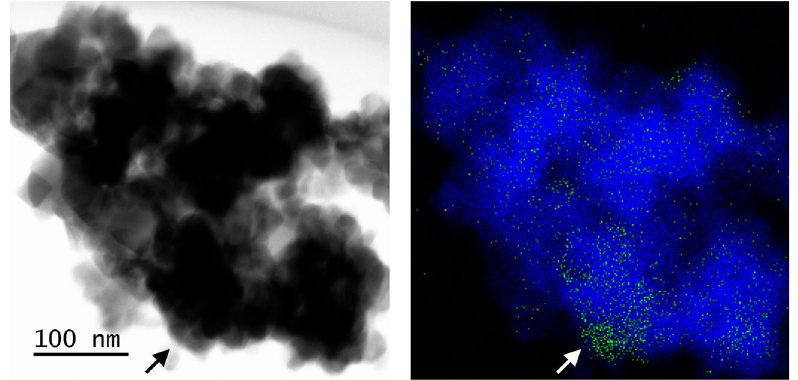
Figure 4. (left) TEM image and (right) EDX mapping analysis of 5.0 wt% Ru/SnO 2 . The blue and green dots correspond to the Sn − L and Ru − K fluorescence lines, respectively.